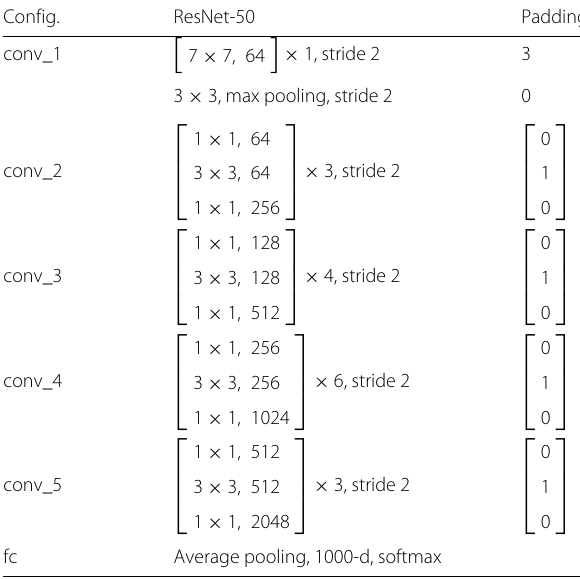
Table 1 Configurations of the ResNet-50 Config.